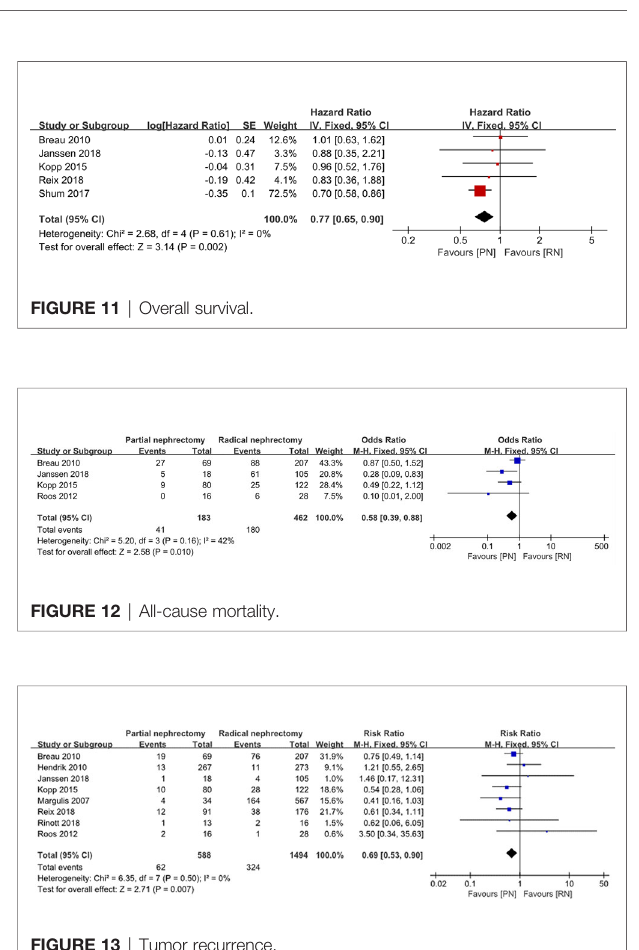
FIGURE 13 | Tumor